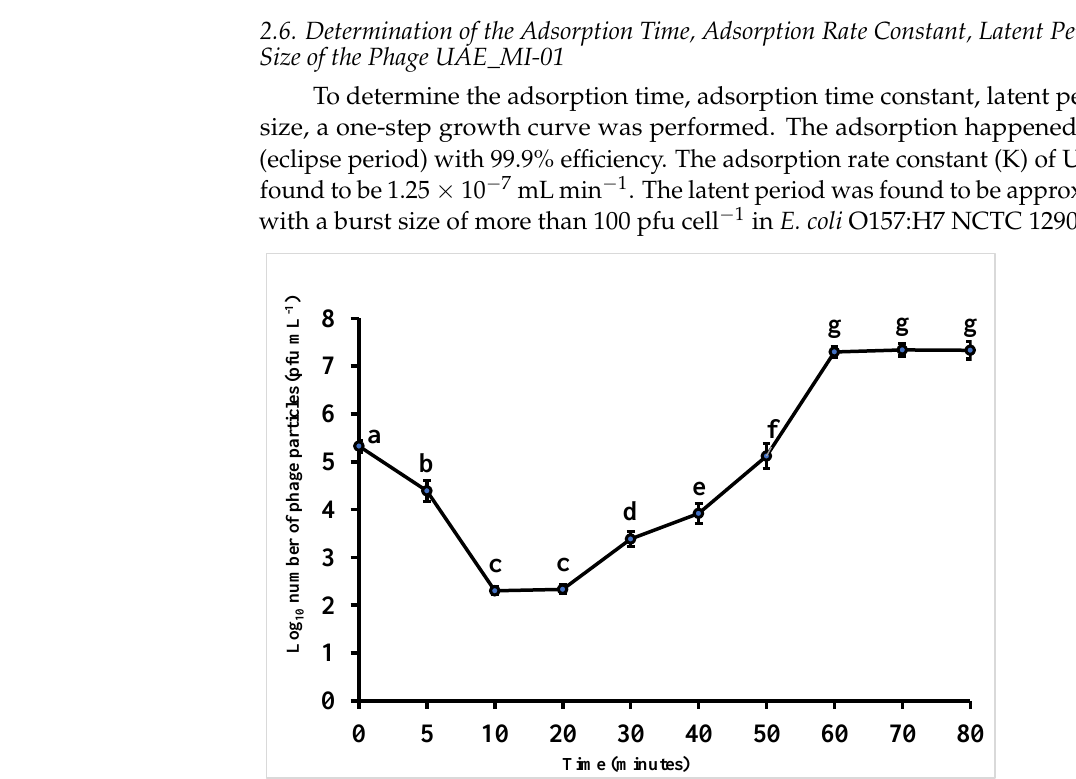
Figure 2. One step growth curve of phage UAE_MI-01 with Escherichia coli O157:H7 NCTC 12900 as the propagation host. Values are means ± standard deviation of four replicates for each timing. Mean values followed by different letters are significantly ( p < 0.05) different from each other according to Fisher’s Protected LSD Test. Bars represent standard deviation. Pfu = plaque forming